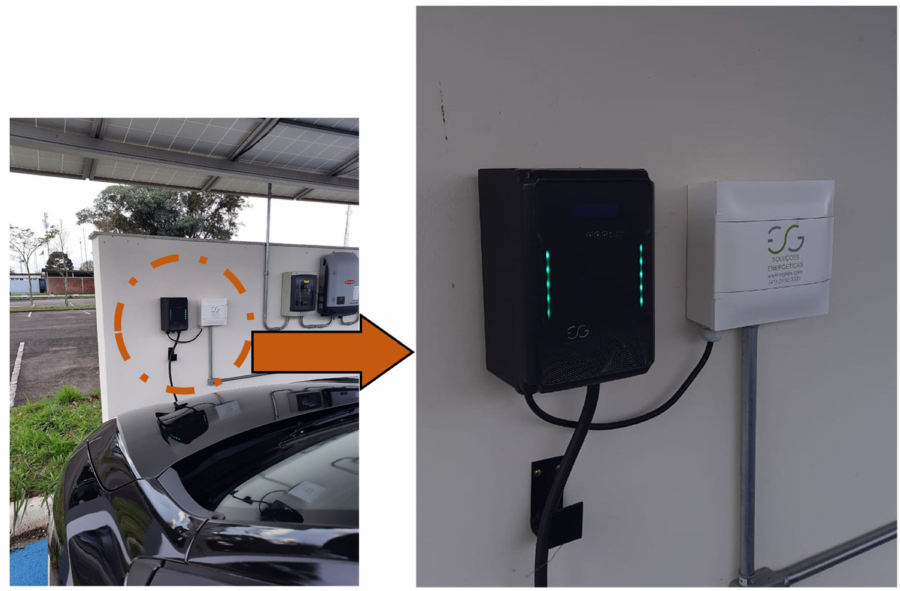
Figure 2. EGNEX ProEV1